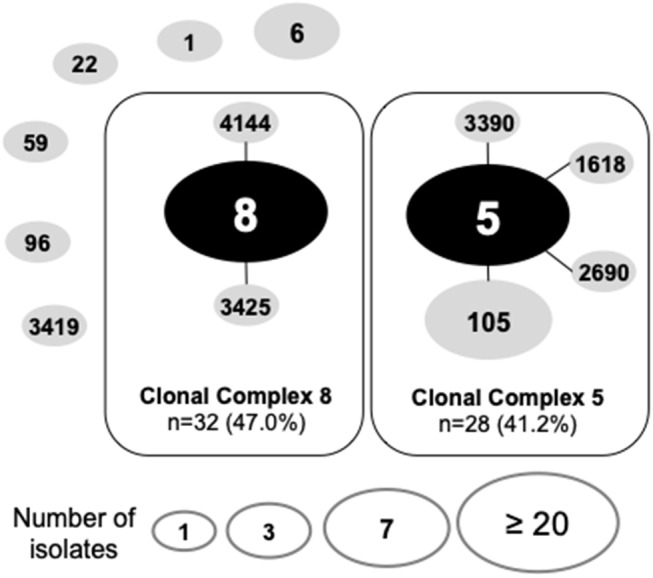
Go eBurst-based population structure of ocular MRSA strains (n = 68). Each ST is represented by a circle. Lines connect single-locus variants. The black circles represent clonal complex founders. Circles not connected represent singleton STs in this particular population structure.